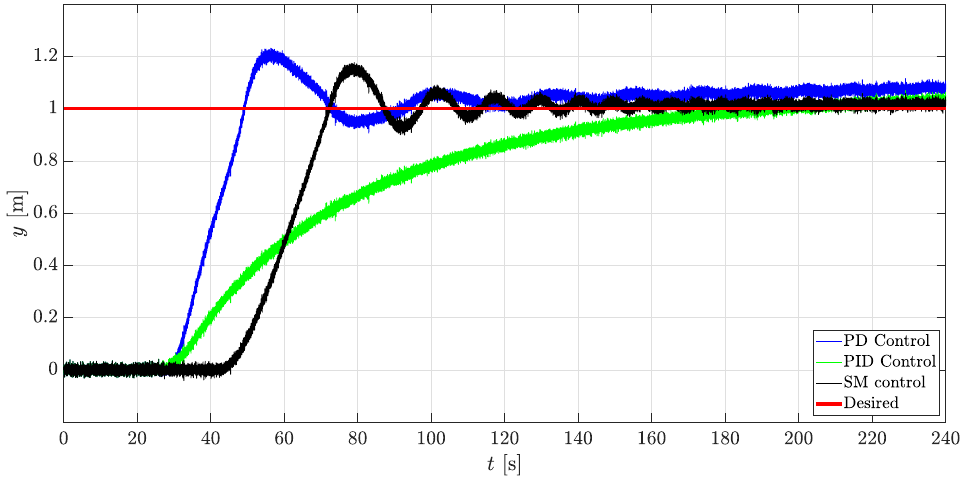
Figure 15. Translational behavior of the mini-AUV along I y